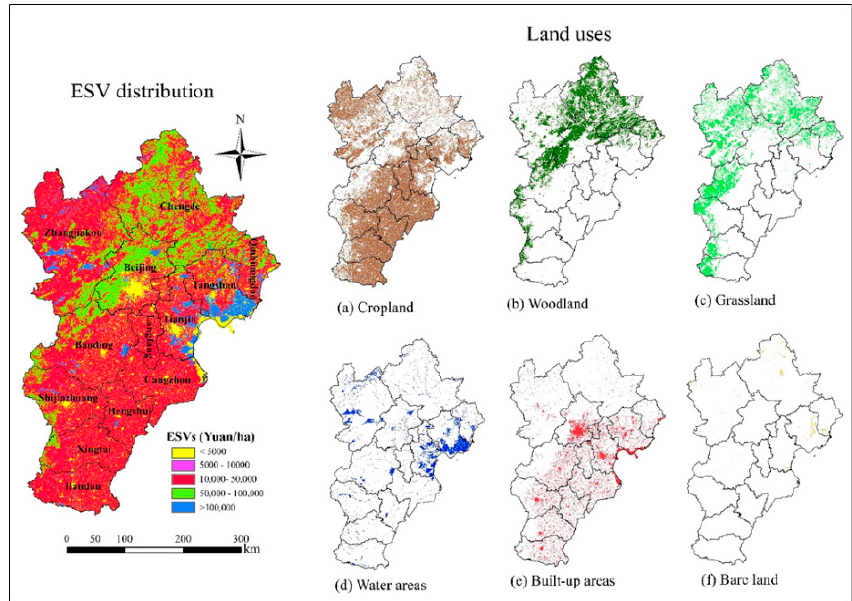
Figure 4. Spatial distribution of ecosystem service values and land uses in the Jing-Jin-Ji region.